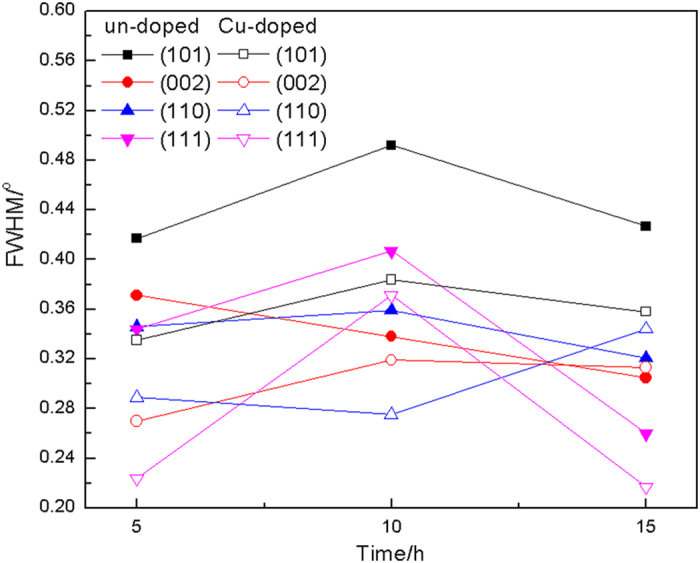
FWHM of the un-doped and Cu-doped samples prepared at 600 °C for 5 h, 10 h and 15 h.The corresponding planes of MgB2 are (101), (002), (110) and (111), respectively.